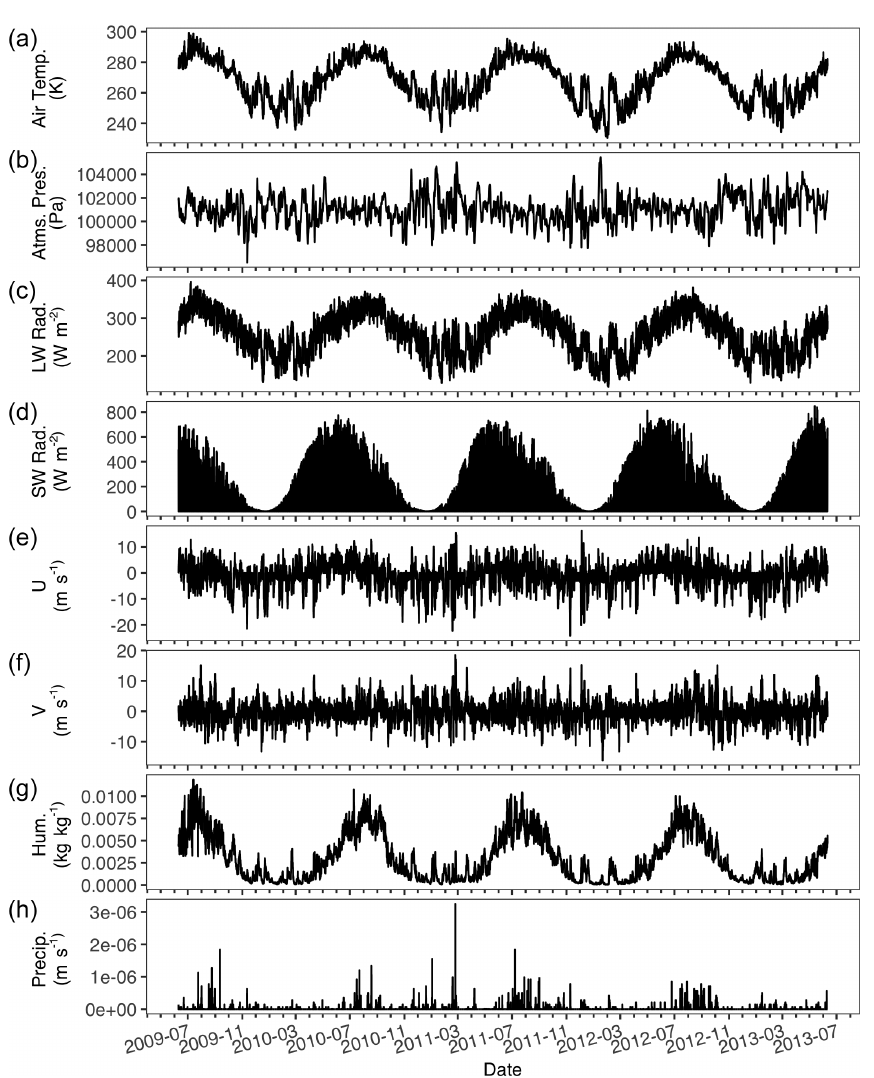
Figure A2. Fox Den hourly meteorological data used in simulations. Air temperature (K) (a) , atmospheric pressure (Pa) (b) , longwave radiation (Wm 2 ) (c) , shortwave radiation (Wm 2 ) (d) , two-component wind speed (ms − 1 ) (e, f) , humidity (kgkg − 1 ) (g) , and precipitation (ms − 1 ) (h)